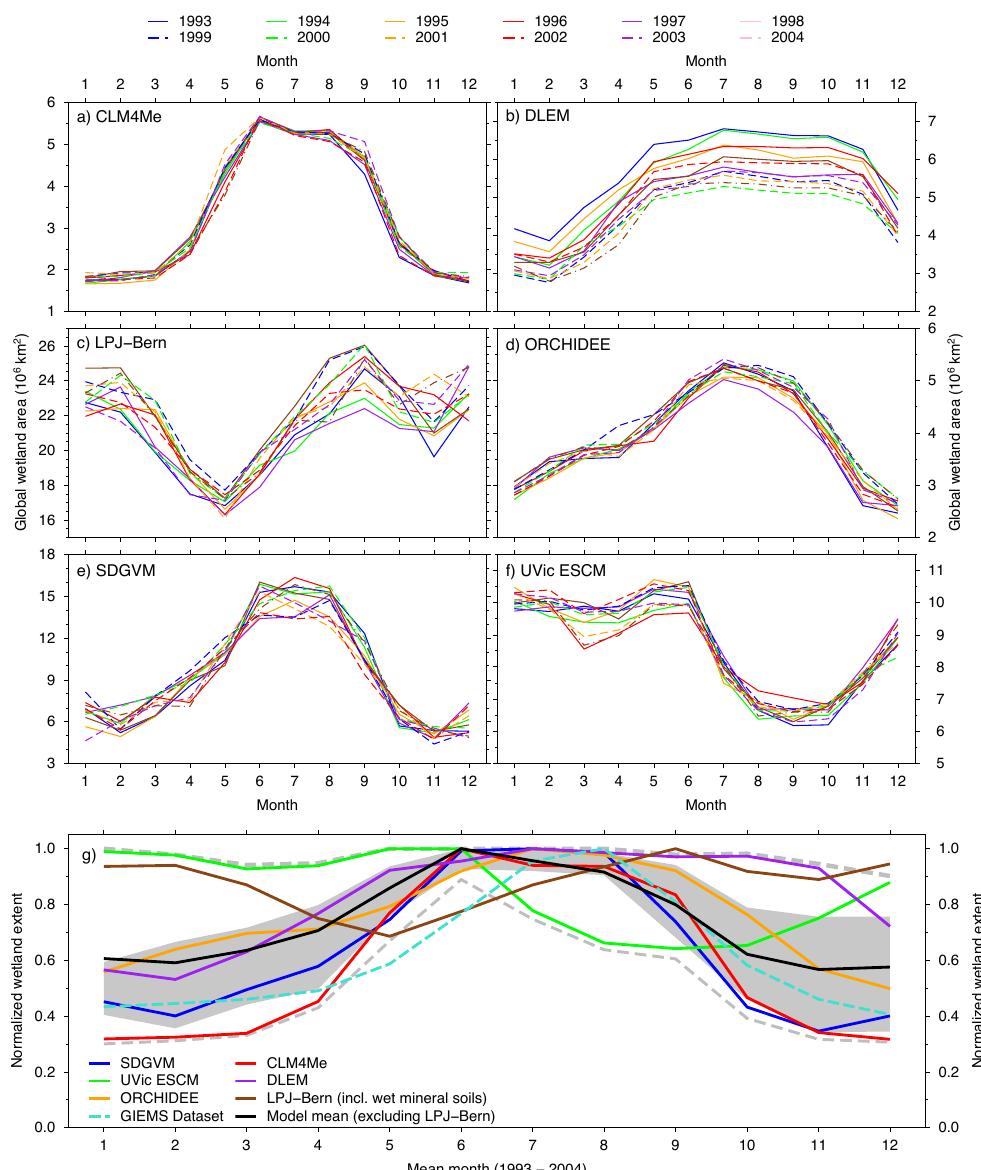
Fig. 2. Monthly global wetland extent for 1993–2004 for all models that do not use an external dataset for calculation of intra- and/or inter- annual variability. Plot (g) is the normalized monthly global wetland extent for all models in plots (a)–(f) , the unaltered GIEMS inundation dataset, as well as the mean extent of the models (excluding LPJ-Bern due to its wet mineral soils parameterization). The grey shading denotes the 25th and 75th percentiles of the model distribution (excluding LPJ-Bern). The grey dashed lines are the 5th and 95th percentiles.